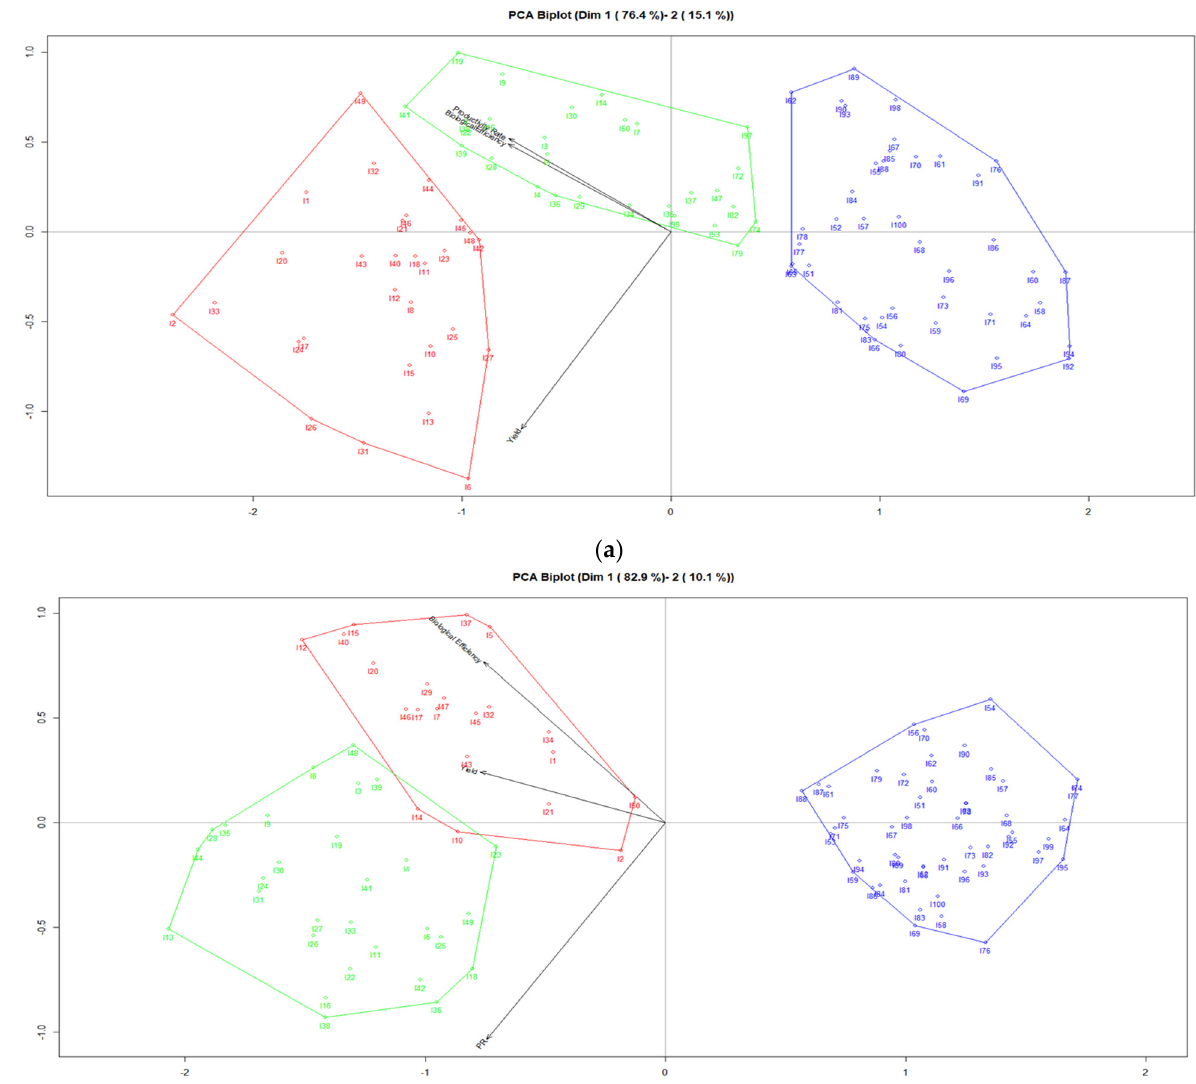
Figure 2. ( a ) PCA Biplot for productivity parameters of Pleurotus ostreatus , ( b ) PCA Biplot for productivity parameters of Pleurotus djamor .